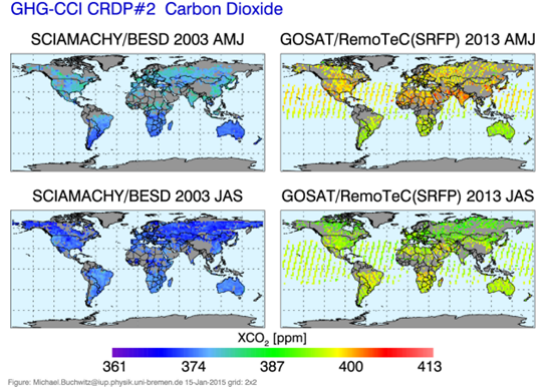
Fig.2: GHG-CCI CRDP#2 XCO 2 products.